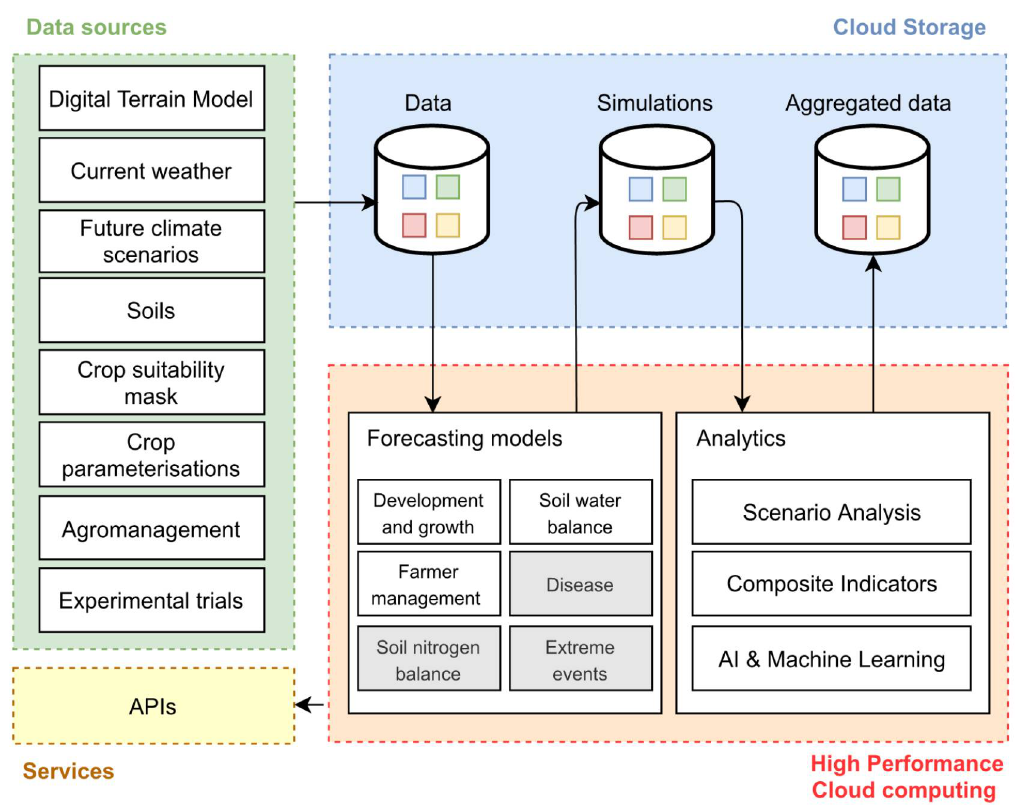
Figure 3. Schematic representation of the simulation environment developed for the AGROENER project (http://agroener.crea.gov.it/; accessed on 19 May 2019). Processes indicated in grey boxes were not considered in the present study.